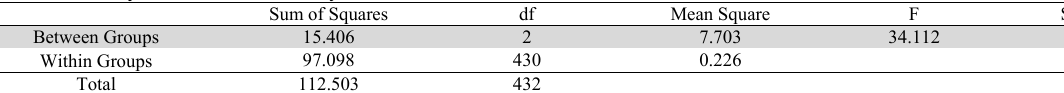
Results of Analysis of Variance for